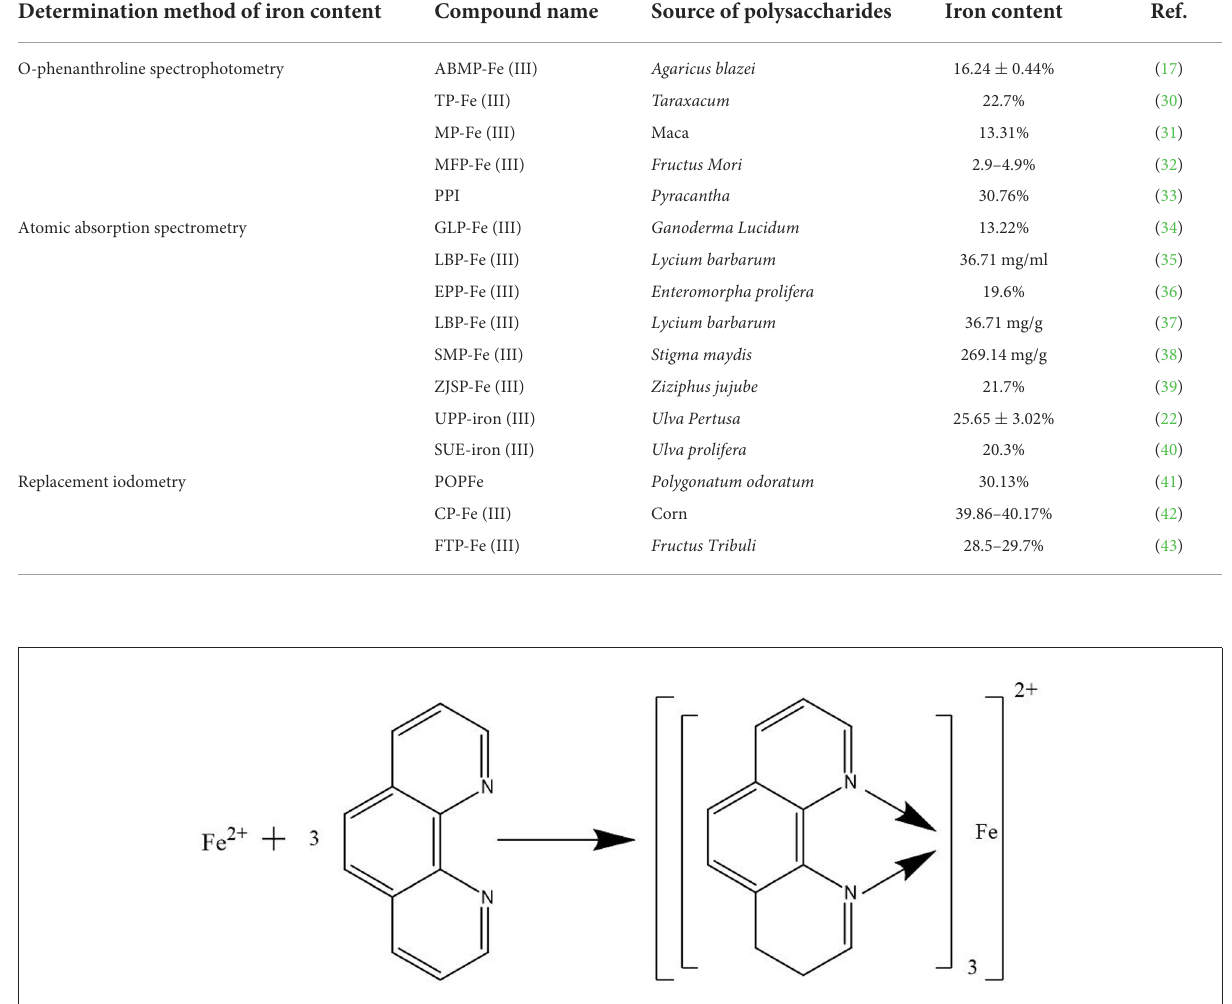
FIGURE3 Diagram of iron and phenanthroline